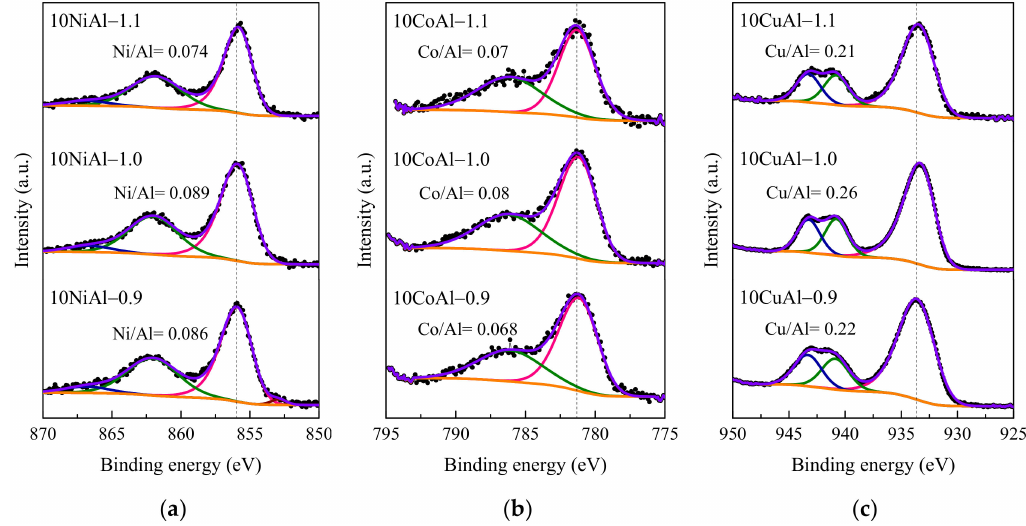
Figure 6. ( a ) Ni 2p 3 / 2 , ( b ) Co 2p 3 / 2 and ( c ) Cu 2p 3 / 2 XP spectra for 10MAl − x calcined